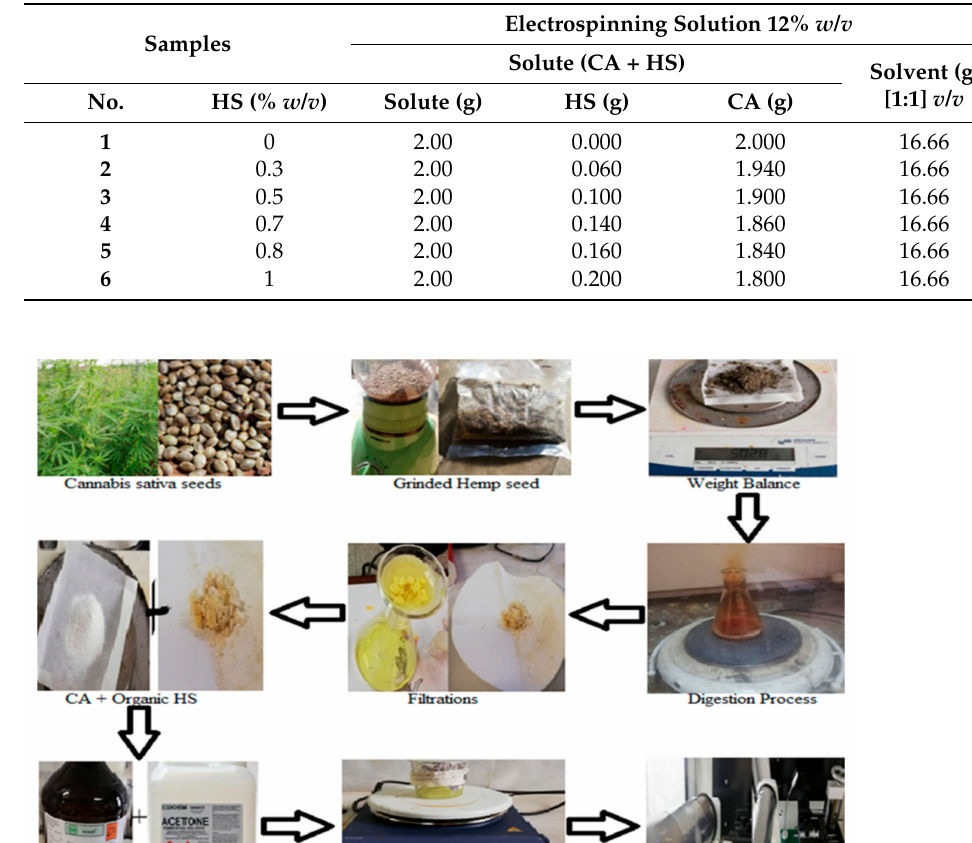
Table 1. Each sample composition with 12% concentration.